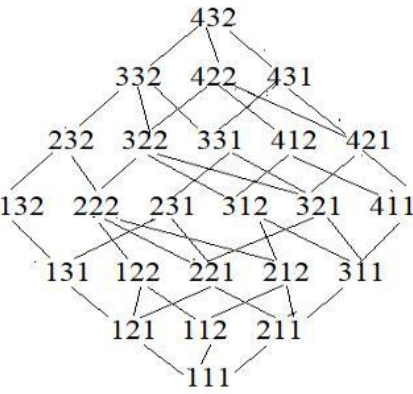
Figure 1. Partial ordered lattices of scale